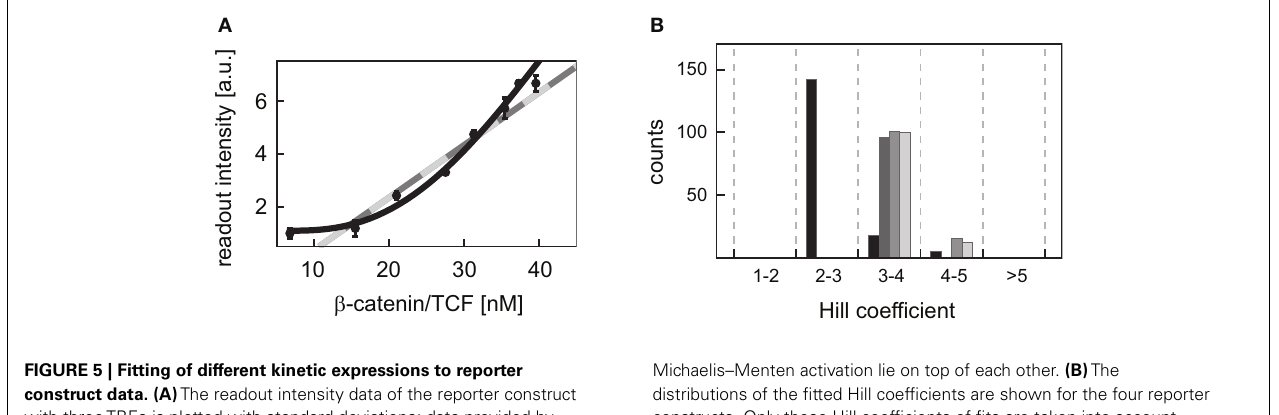
FIGURE 5 | Fitting of different kinetic expressions to reporter construct data. (A) The readout intensity data of the reporter construct with threeTBEs is plotted with standard deviations; data provided by Biechele and Moon (2008).The respective linear activation function (light gray), Michaelis–Menten activation function (dark gray), and Hill-type activation function (black) realizing the best fit (i.e., yielding the minimal log-likelihood function value) are shown.The fits of the linear and the